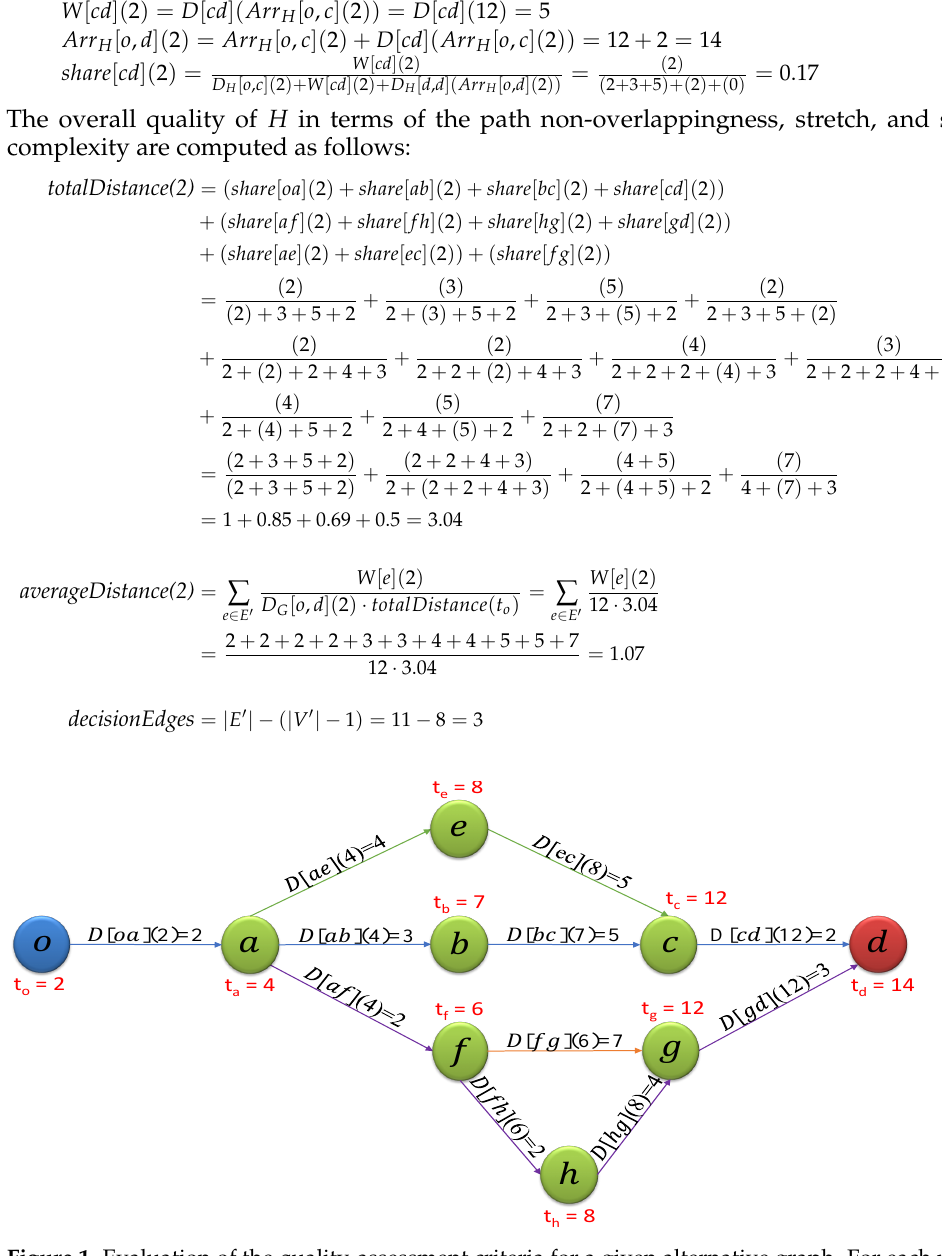
Figure 1. Evaluation of the quality-assessment criteria for a given alternative graph. For each node x , t x = Arr [ o , x ]( 2 ) is the earliest arrival time at x , for departure time t o = 2. We assume that D H [ o , d ]( 2 ) = D G [ o , d ]( 2 ) . The minimum travel time is D H [ o , d ]( 2 ) = 12 via (cid:104) oa , ab , bc , cd (cid:105)